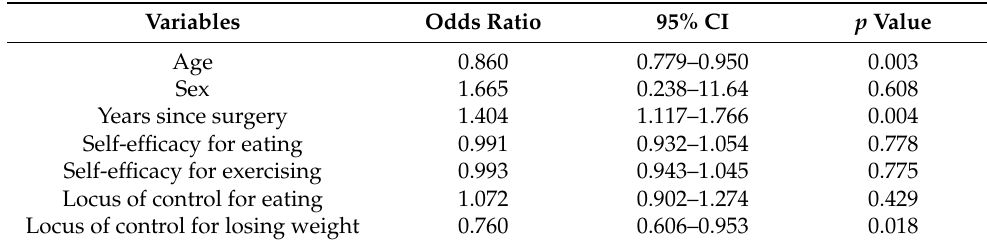
Table 5. Multiple logistic regression